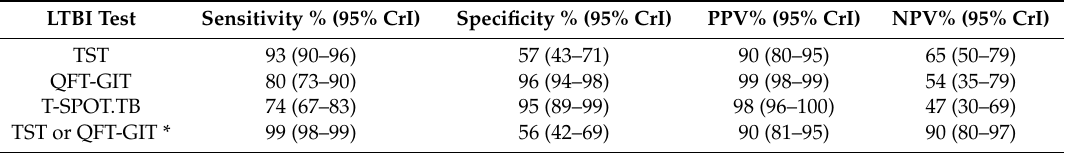
Table 4. Performance of diagnostic tests for latent tuberculosis infection in healthcare workers using a latent class model using more informative prior information on specificities only (N = 472). LTBI Test